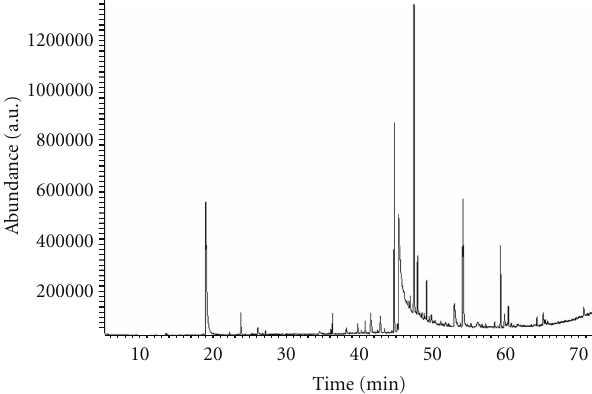
Figure 3: Gas chromatogram of polar volatile compounds of powder fructan obtained with PEG fiber and Stabilwax capillary column.